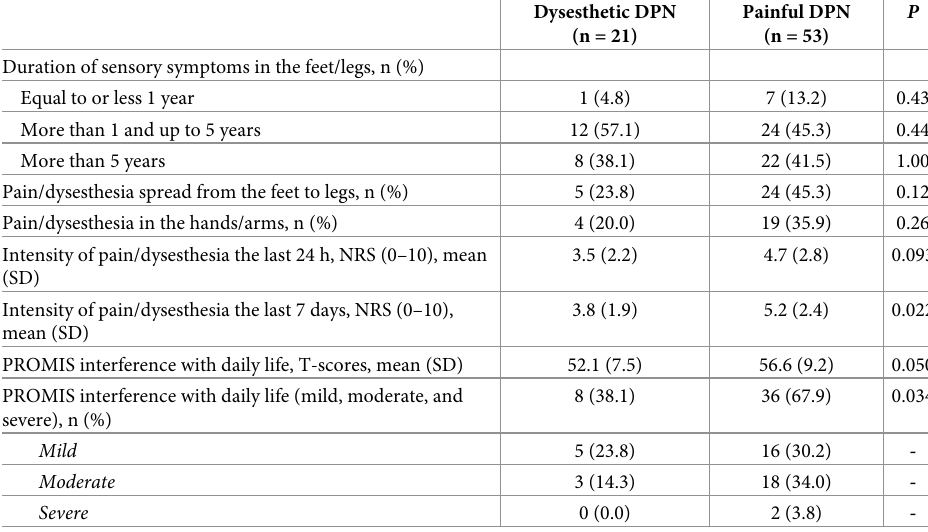
Table 2. Duration, intensity, and interference with daily life of pain and